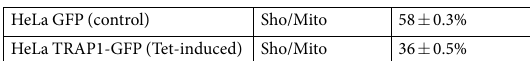
The proteasomal pathway in “prion-like” properties of Sho.